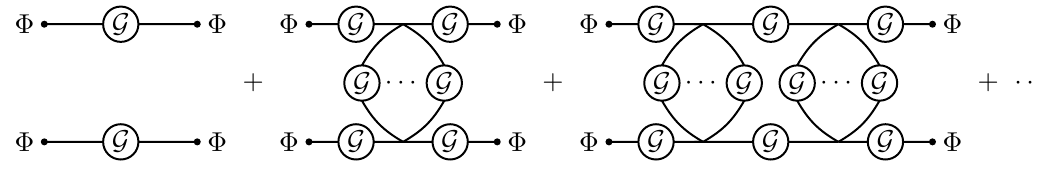
Figure 5. The leading 1 =N correction to the four-point function of super(cid:12)eld (cid:8) A q